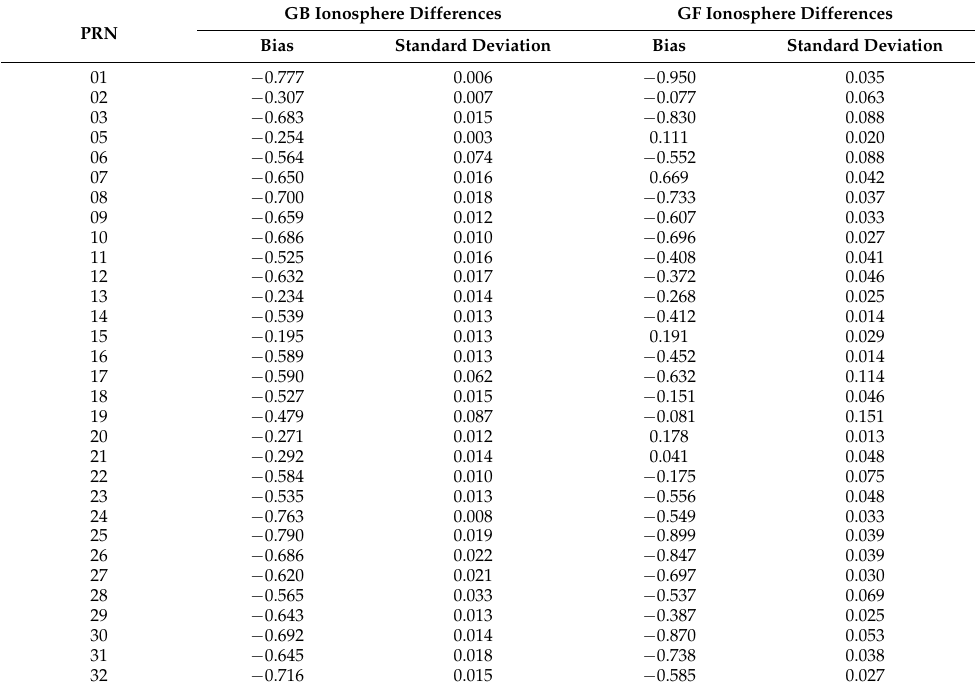
Table A2. Statistics of Figure 9. GB ionospheric delay differences and GF filtered ionospheric delay differences between the receiver GODZ and